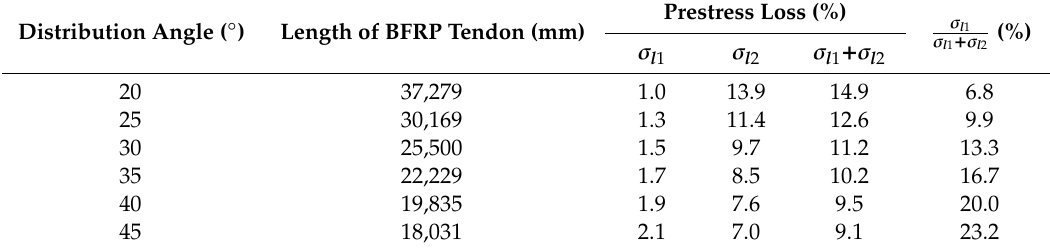
Table 5. Theoretical prestress loss of BFRP tendons given the slab width of 12.75m. Distribution Angle ( ◦